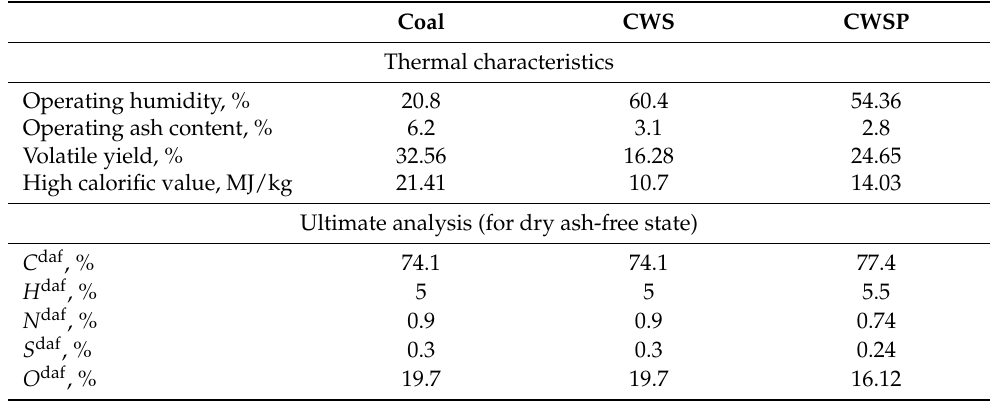
Table 1. Main fuel characteristics.